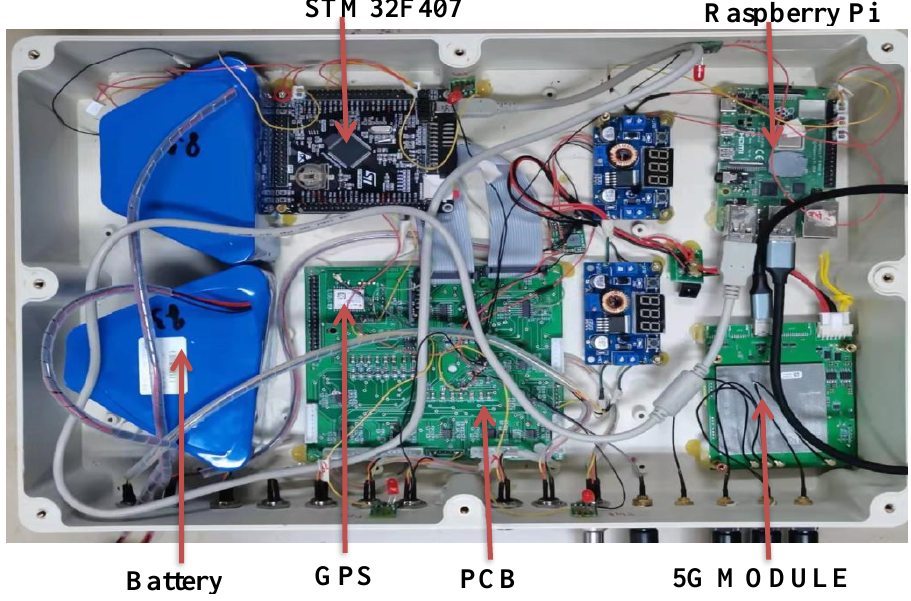
Figure 4. Components of the seismograph assembled in a box.